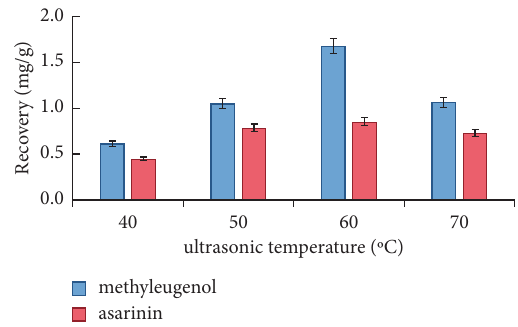
Figure 6: Effect of ultrasonic temperature, extraction conditions: sample amount, 50mg; molar ratio, 1 :2; DES volume, 1.5 mL; ultrasonic time, 30min; and vortex oscillation, 5min.